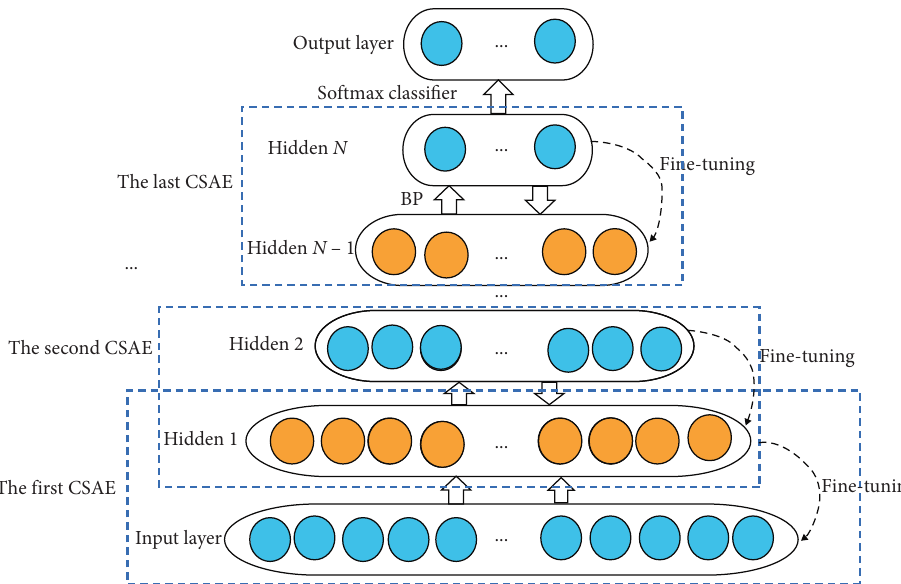
Figure 2: The architecture of DCSAE